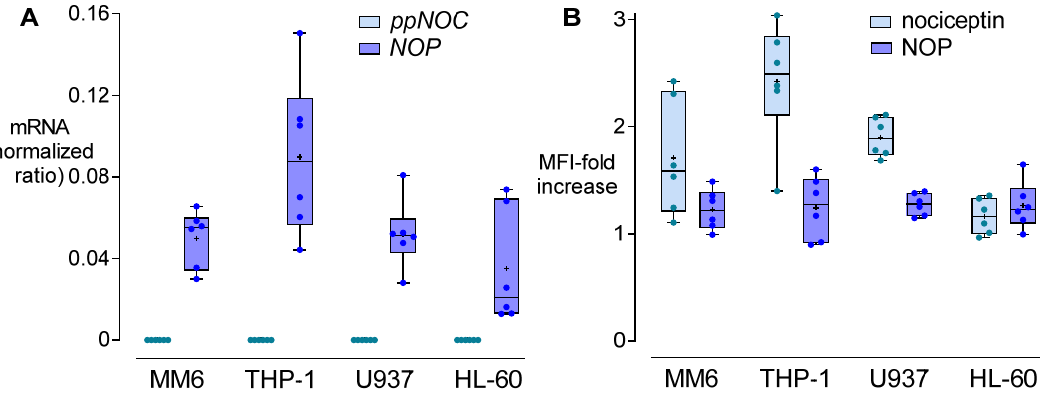
Figure 1. Constitutive expression of nociceptin and NOP in different human cell lines. ( A ) Preprono ‐ ciceptin ( ppNOC ) and NOP mRNA expression in human monocytic cell line MM6, THP ‐ 1, U937, and lymphoblast cell line HL60. ( B ) Intracellular nociceptin and cell membrane NOP protein levels in four cell lines. Flow cytometry data are presented as mean fluorescence intensity (MFI) related to the respective isotype controls. Boxplots with individual data points, median, IQR, and mean “+”; n = 6.